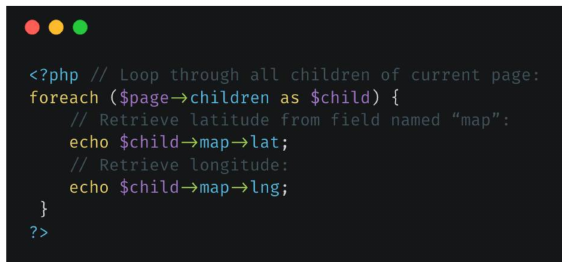
Figure 8. Simplified PHP (Hypertext Preprocessor) code used to retrieve coordinates for a group of items in a branch below (e.g., items in a municipality or in a sequence). Screenshot by the N-340 research team, January 2018.